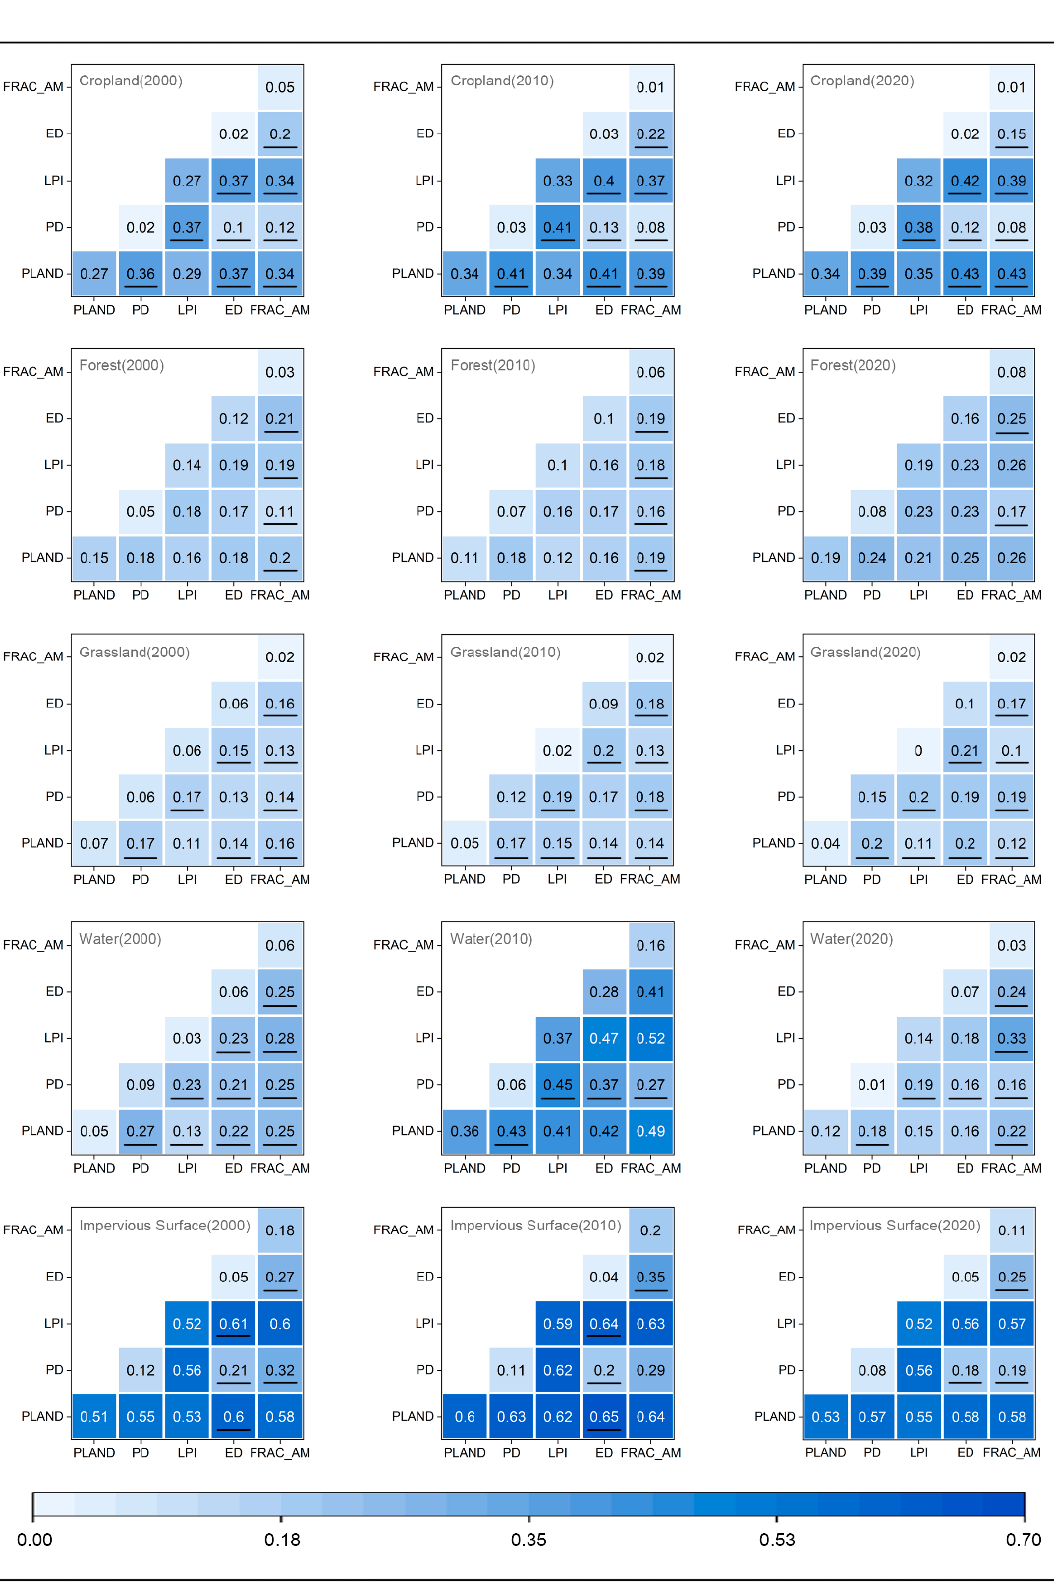
Figure 11. Results of the class-level interaction detector.